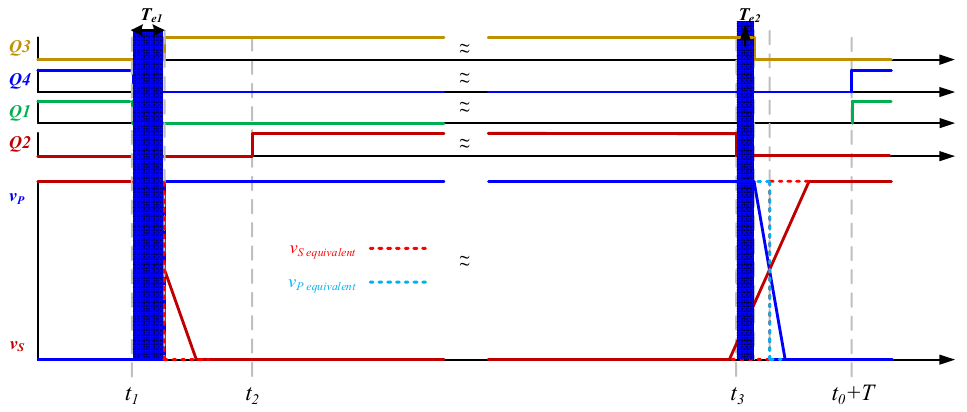
Figure 17. Operation sequence diagram of a stacked buck converter with low output ripple dead time modulation (zoom in). The dead time t 1 ~t 2 and t 3 ~t 0 +T interval must be sufficiently long to enable the comple-